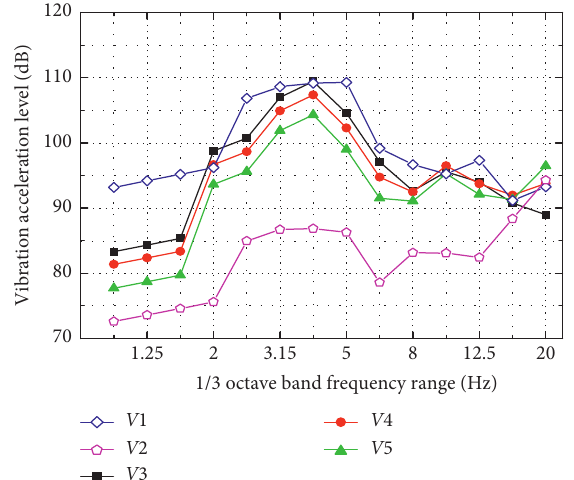
Figure 11: Measured vibration acceleration level spectrum of